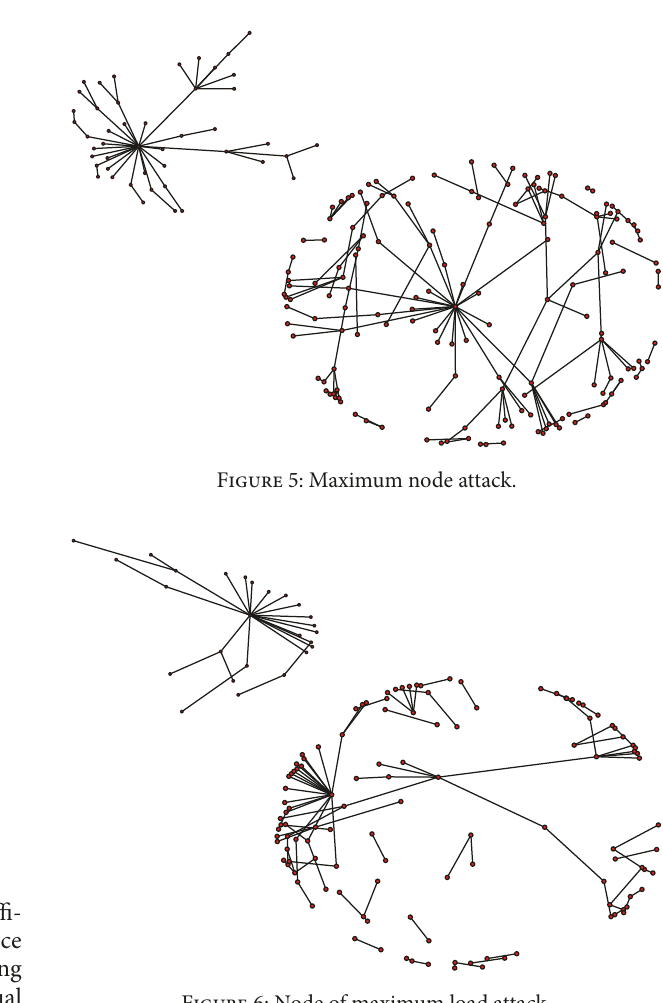
Figure 6: Node of maximum load